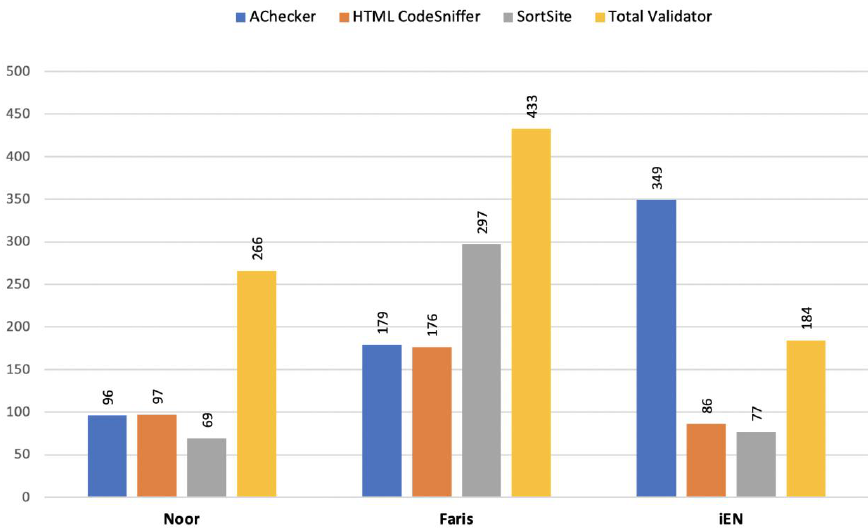
Figure 6. Comparison based on the tools’ performances (total number of errors).